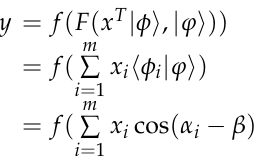
Figure 2. Diagram of quantum weighted neuron model.